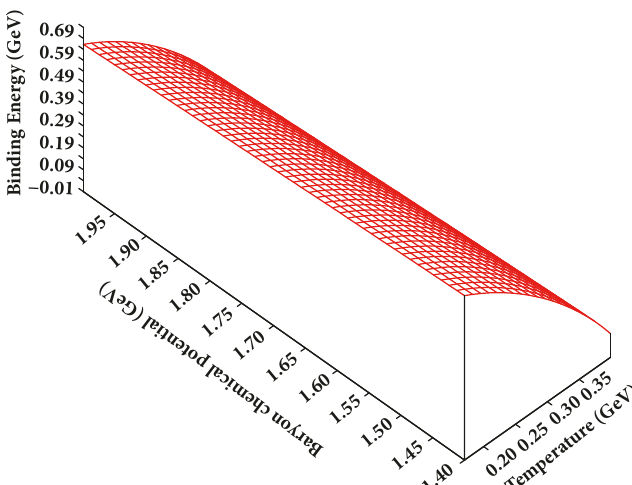
Figure 6: The binding energy of 1S charmonium is plotted as a function of temperature and baryonic chemical potential in 3D space in the isotropic medium ( 𝜉 = 0).